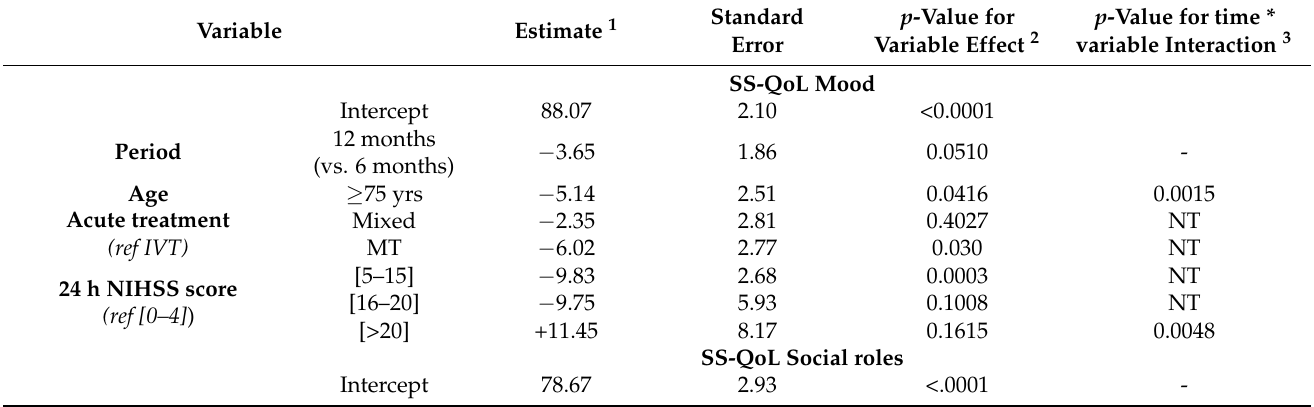
Table 5. Multivariate analysis of characteristics associated with SS-QoL domains mood and social